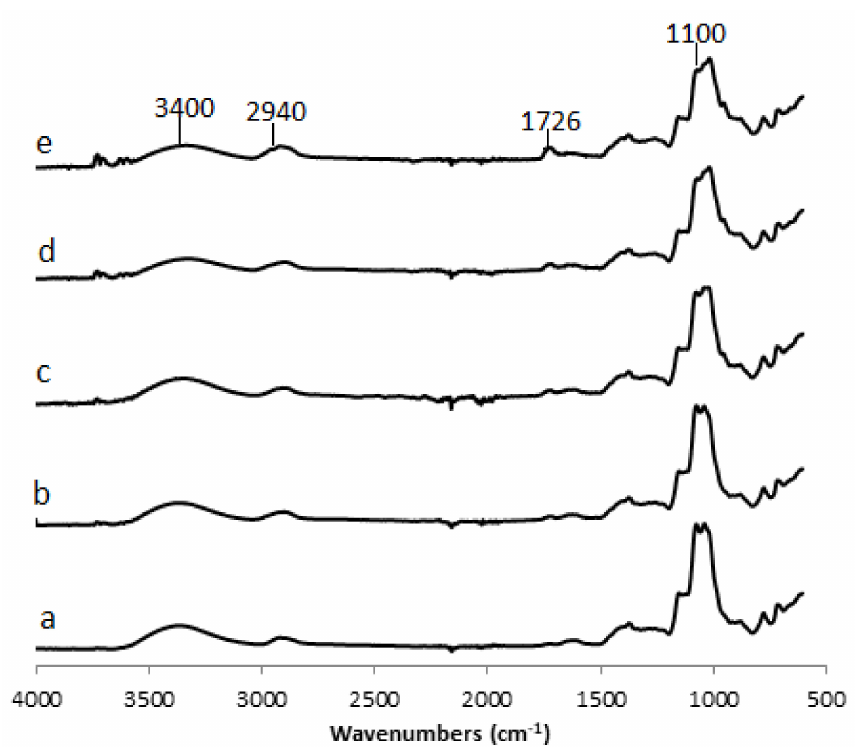
Figure 6. FTIR spectra for CG–TPSA adducts from the bottom to the top: a ) sample T1, b ) sample T2, c ) sample T3, d ) sample T4, and e ) sample T5.